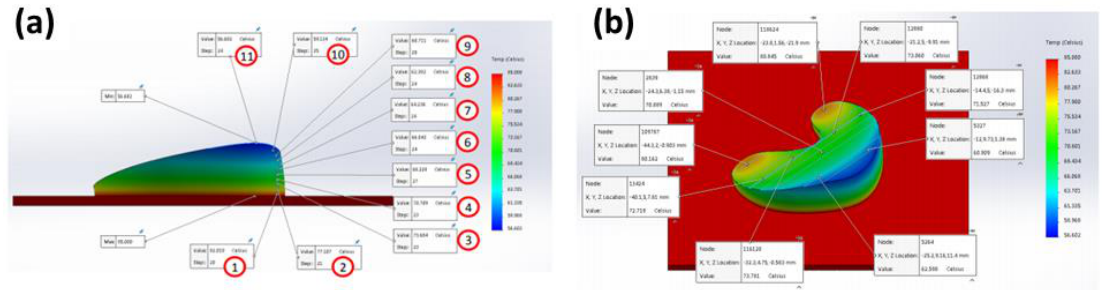
Figure 14. ( a ) Vertical and ( b ) horizontal temperature distribution of the 3D printed silicone meniscus implant using one convection block simulation.